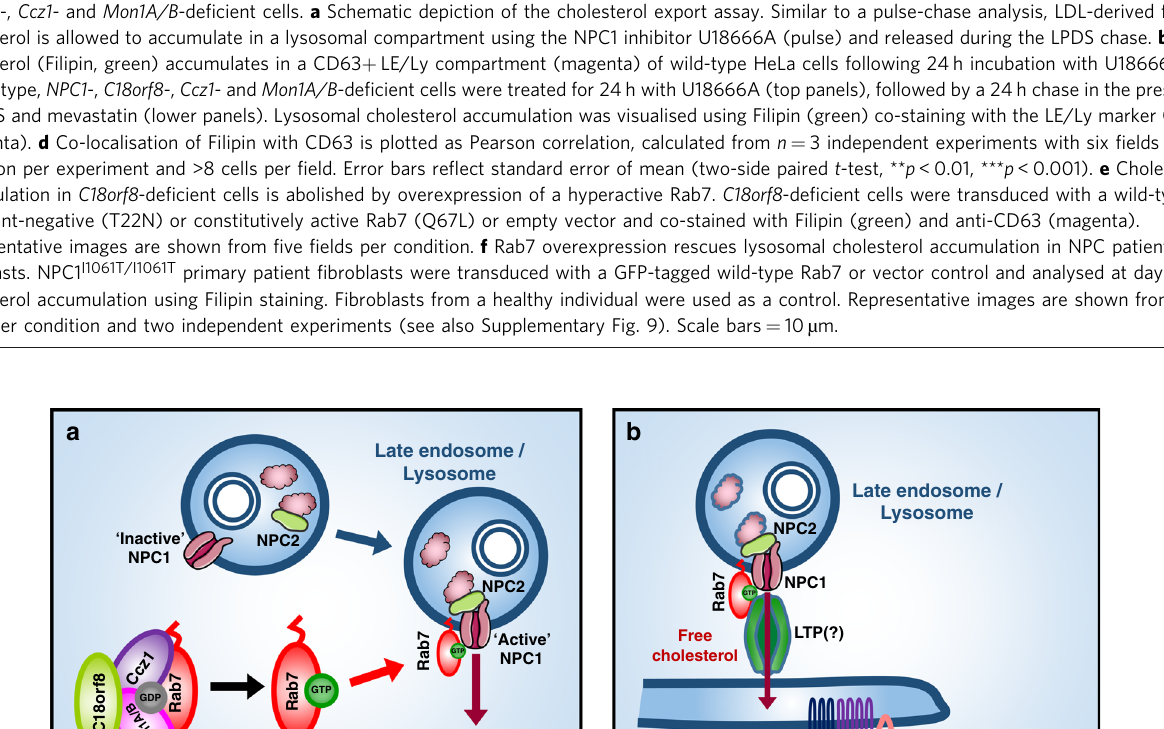
Fig. 10 A trimeric Rab7 GEF controls NPC1-dependent lysosomal cholesterol export. Model for MCC and Rab7 function in lysosomal cholesterol export. The trimeric Mon1-Ccz1-C18orf8 (MCC) GEF activates mammalian Rab7, which binds the NPC1 cholesterol transporter and either a ) directly activates NPC1 ’ s cholesterol export function; or b ) assembles a down-stream membrane contact site (MCS) at which a yet-uncharacterised lipid transfer protein (LTP) mediates cholesterol transfer to the ER and/or plasma membrane. A combined Rab7 function in NPC1 activation and MCS formation would assure lysosomal cholesterol export only proceeds once a down-stream lipid transfer module is